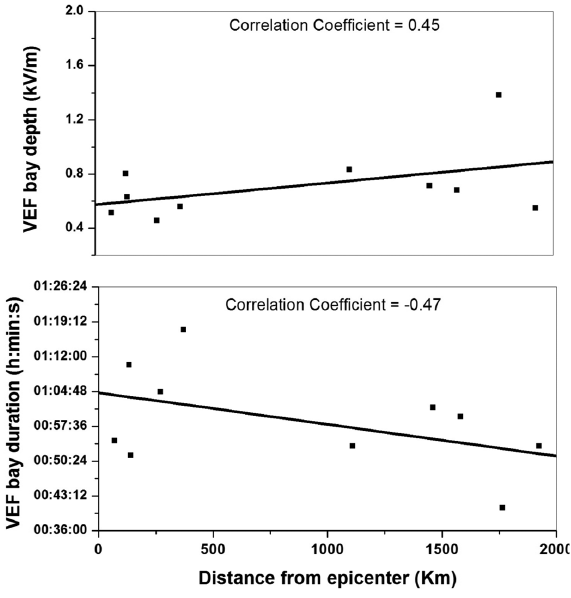
Figure 7. Correlation plot between the time duration of the ob- served precursor of the earthquake and the VEF bay depth (top) and VEF bay duration (bottom).